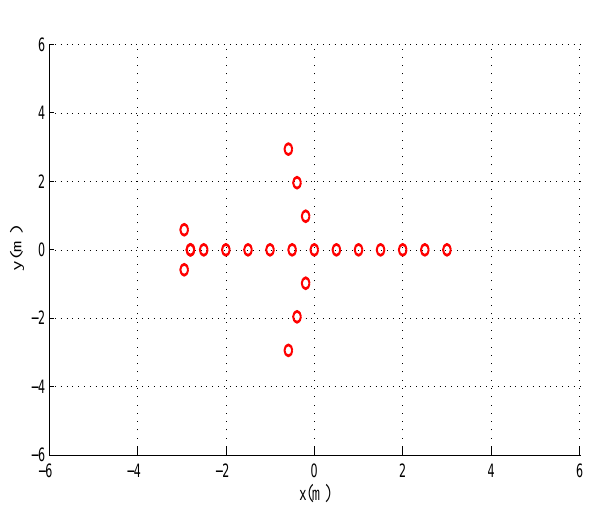
Figure 5. Scattering model of an extended target in the 2D plane.